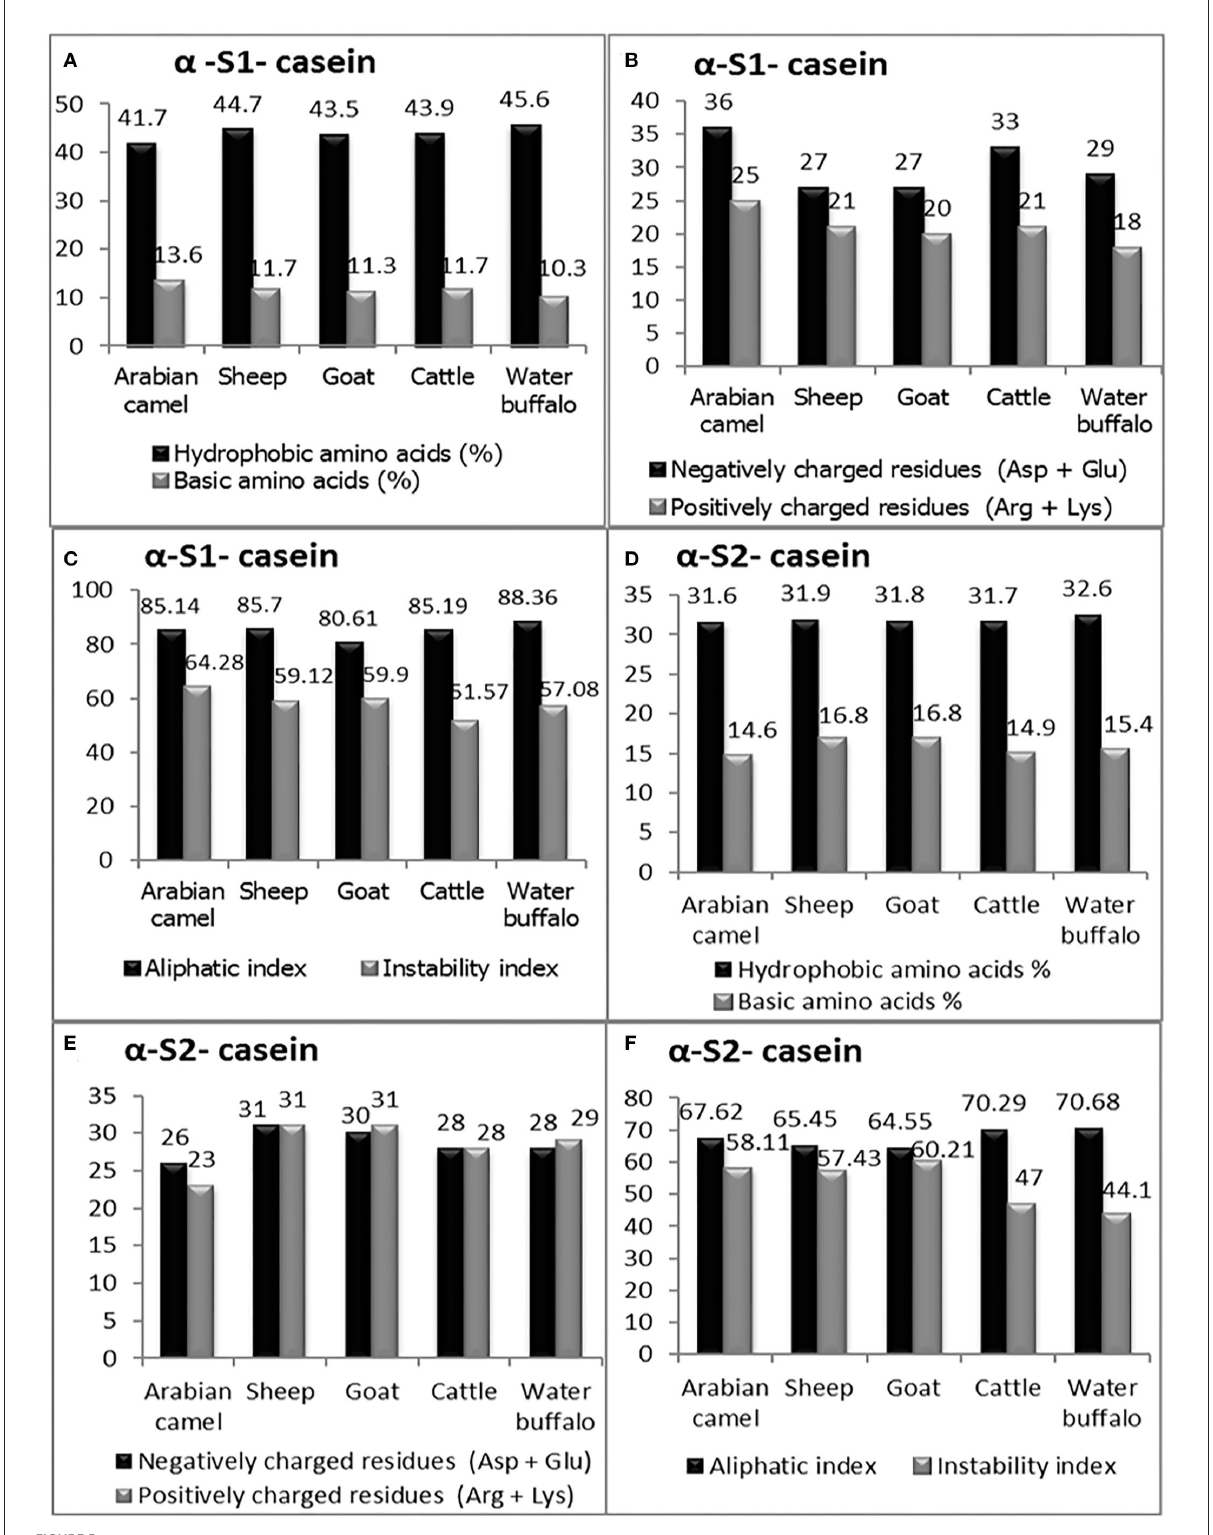
FIGURE5 The computed parameters of α -S1-casein; (A) hydrophobic amino acids (%), basic amino acids (%). (B) Negatively charged residues (Asp + Glu), positively charged residues (Arg + Lys). (C) Aliphatic and instability indexes. The computed parameters of α -S2-casein (D) hydrophobic amino acids (%), and basic amino acids (%). (E) Negatively charged residues (Asp + Glu), positively charged residues (Arg + Lys). (F) Aliphatic and instability